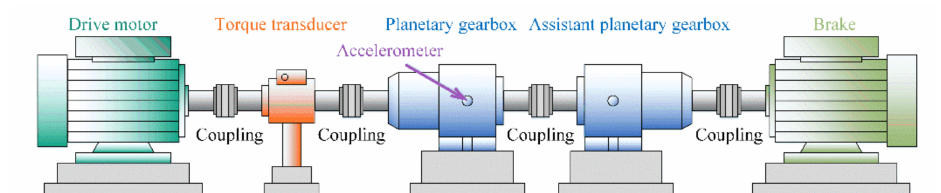
Figure 7. The gearbox test rig.